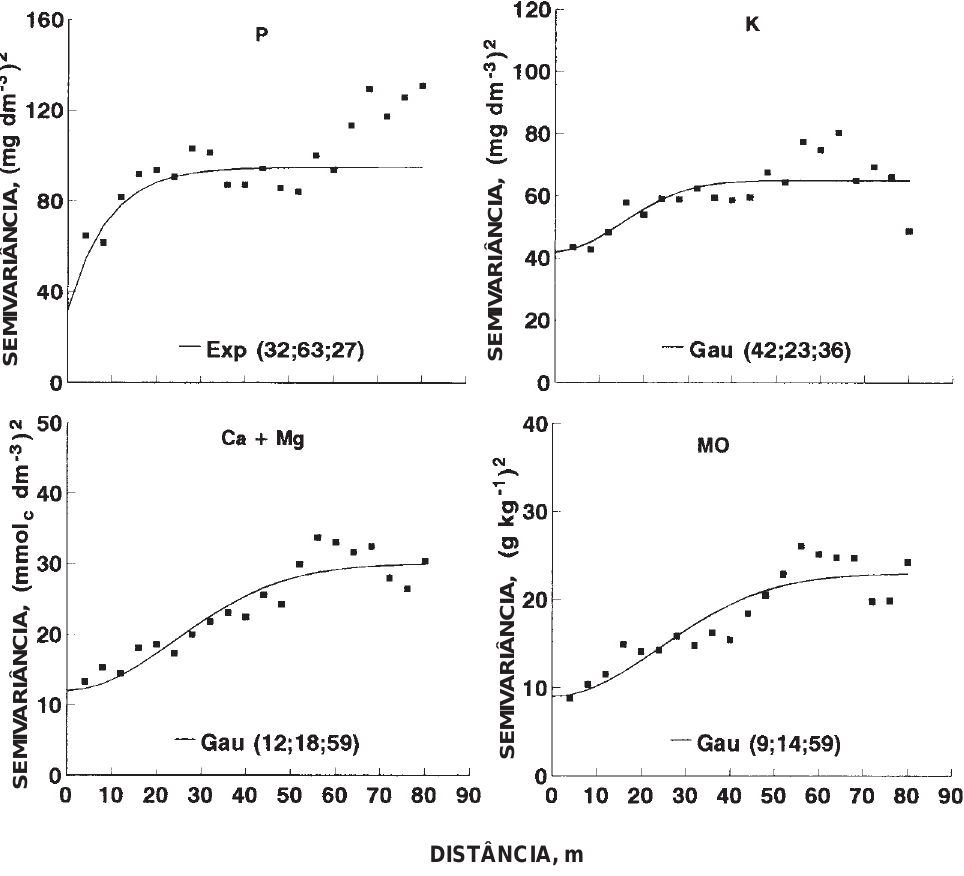
DISTÂNCIA, Figura 1. Semivariogramas para P, K, Ca + Mg e M.O., na avaliação da variabilidade do solo em um pomar cítrico sob manejo uniforme, em Governador Mangabeira (BA). As legendas incluem o modelo ajustado aos dados (Sph = modelo esférico e/ou Exp = modelo exponencial e/ou Gau = modelo gaussiano) e, entre parênteses, os parâmetros C 0 , C 1 e alcance da dependência espacial; C 0 + C 1 representam o patamar do semivariograma .